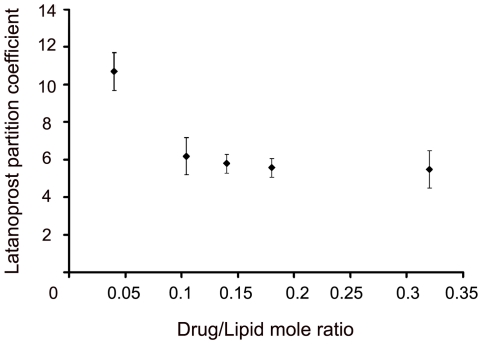
Partition coefficient of latanoprost.Partition coefficient of latanoprost was calculated by taking the ratio of drug concentrations in lipid bilayer and the aqueous buffer. The drugs to lipid loading concentrations (mole ratios) are 0.04, 0.104, 0.14, 0.18, and 0.32 in DPPC. Each partition coefficient value was obtained from the mean of three MLV formulations made and the standard deviations are reported in error bars.